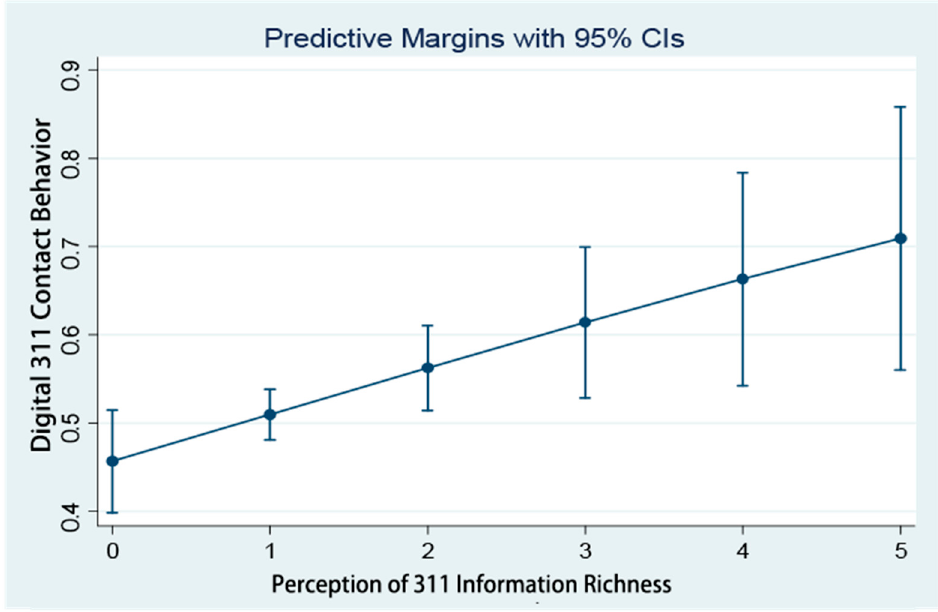
Figure 2. Estimated probabilities of digital 311 contact behavior caused by perception of 311 information richness.